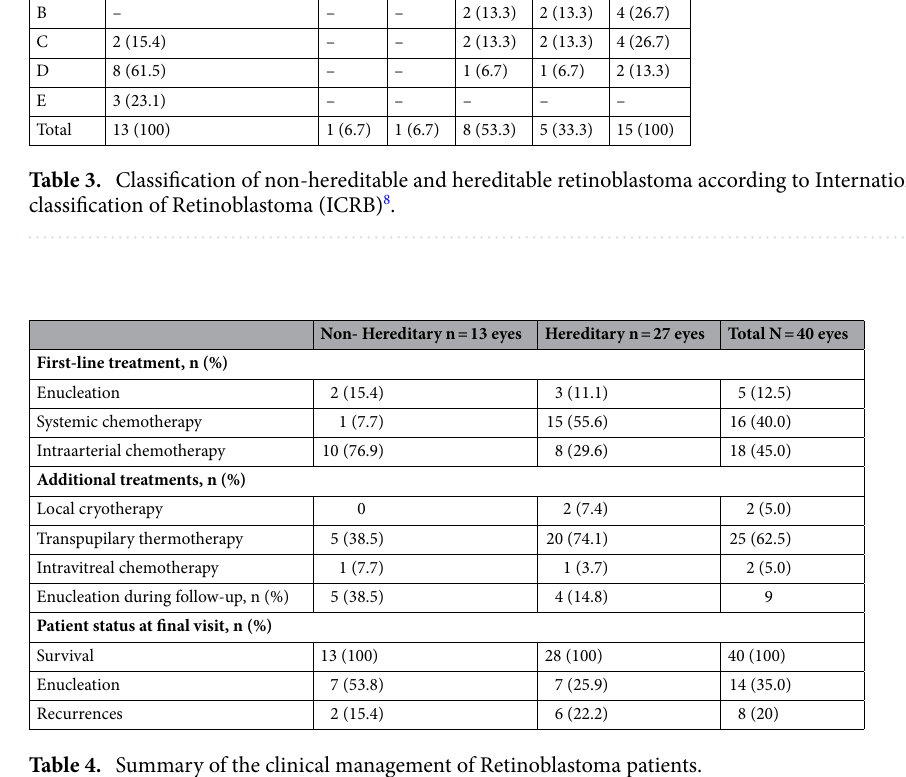
Table 4. Summary of the clinical management of Retinoblastoma patients.